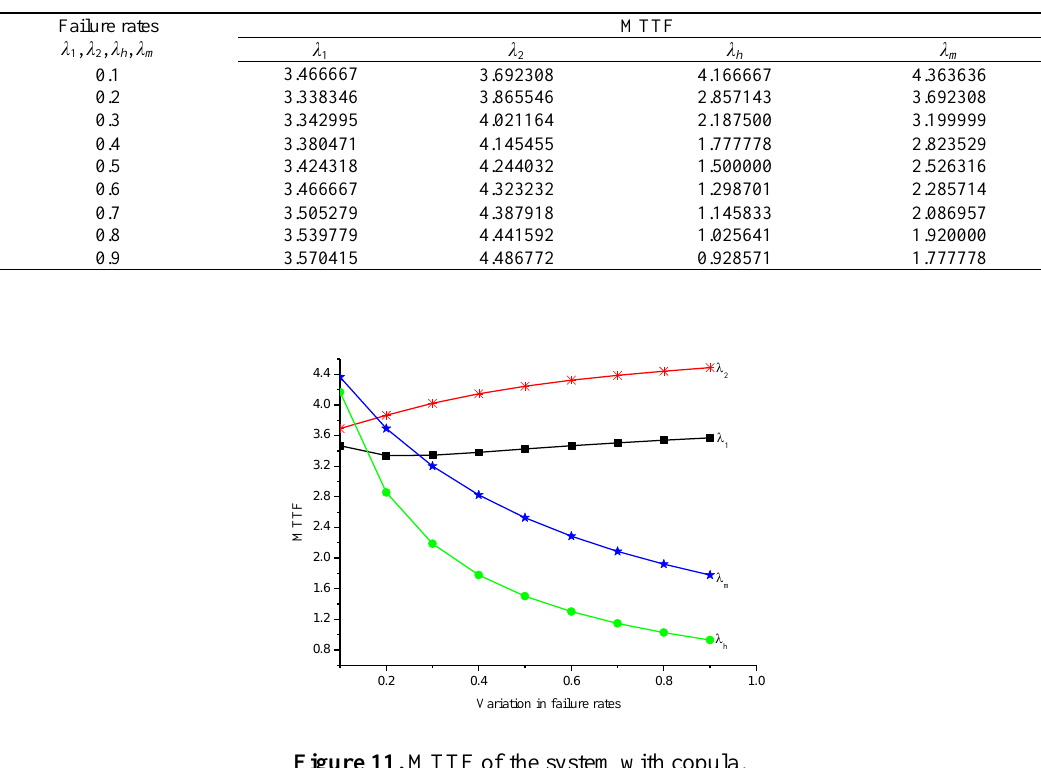
Table 11. MTTF of the system with copula.